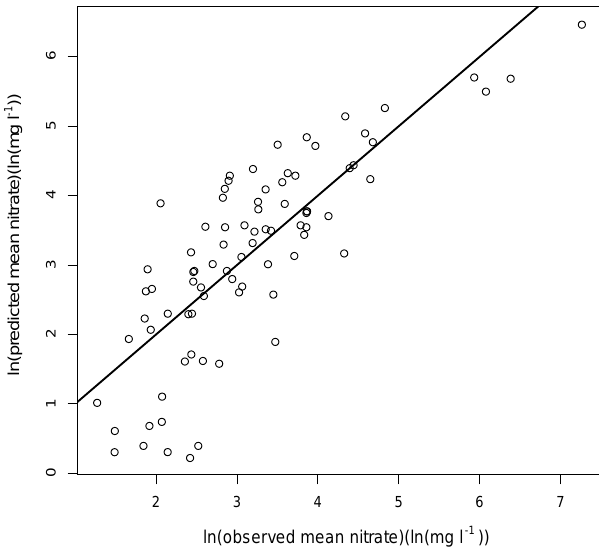
Figure 10. Normal probability distribution of model residuals for the predicted log transformed mean nitrate concentration.